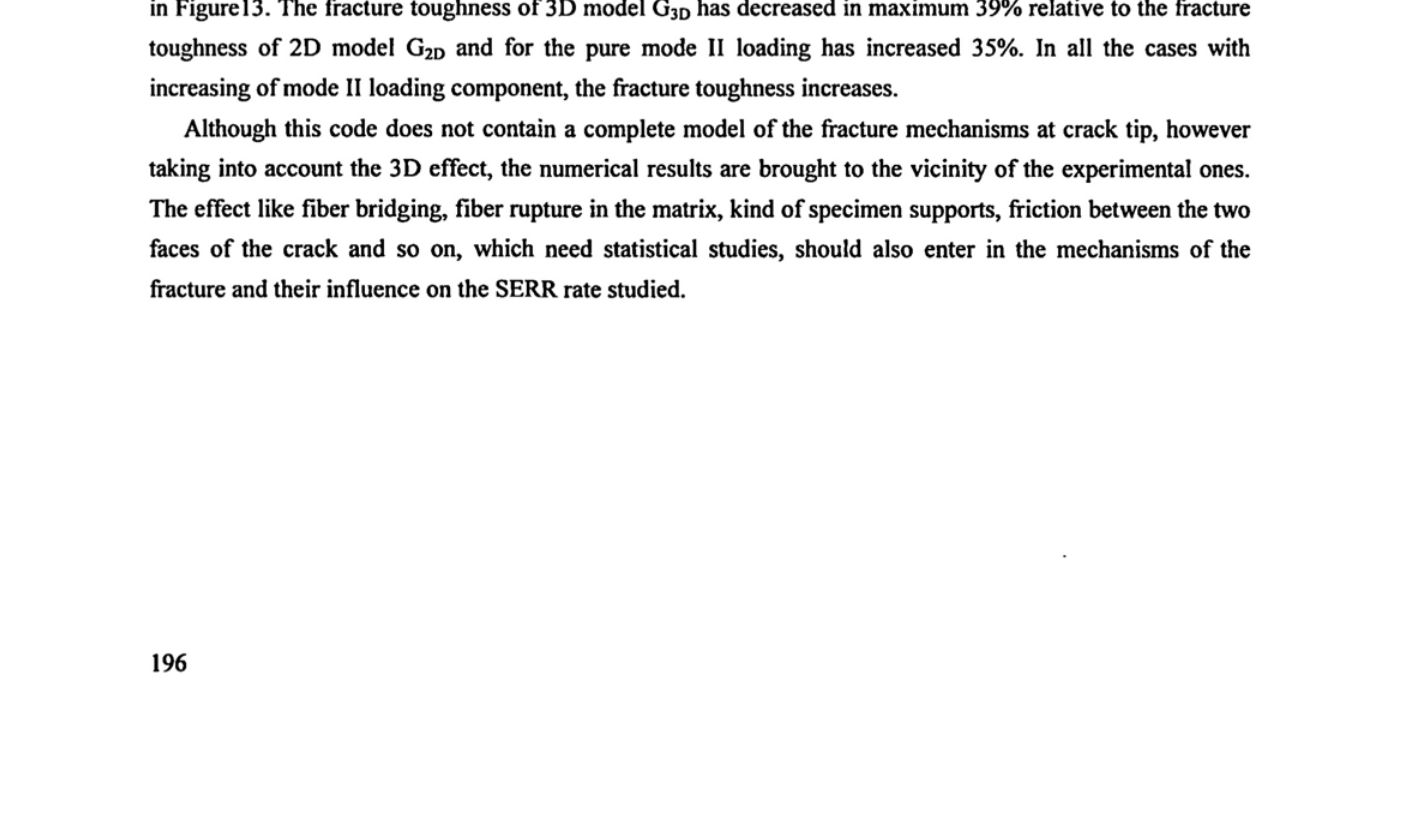
in the crack width with T